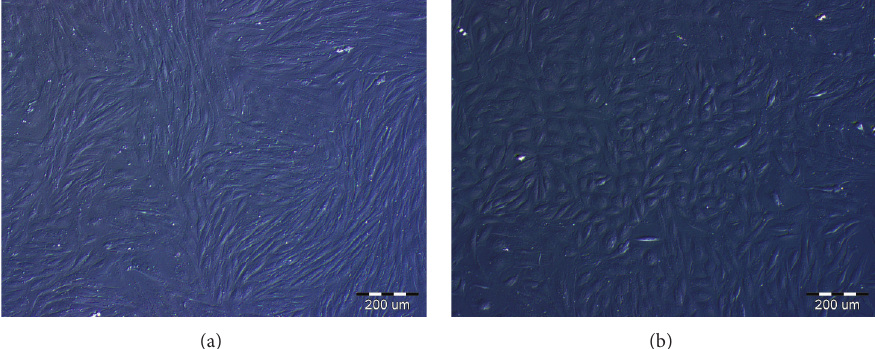
Figure 3: Representative pictures of human endometrial stromal cells observed under inverted microscope (Nikon). (a) Endometrial stromal cells not exposed to hormonal stimuli. The characteristic spindle-like shape of stromal cells is recognizable. (b) Endometrial stromal cells after priming with steroid hormones (E2 + P4 for 12 days). The polygonal shape, typical of decidualized cells, is recognizable. Scale bar = 200 𝜇 m.